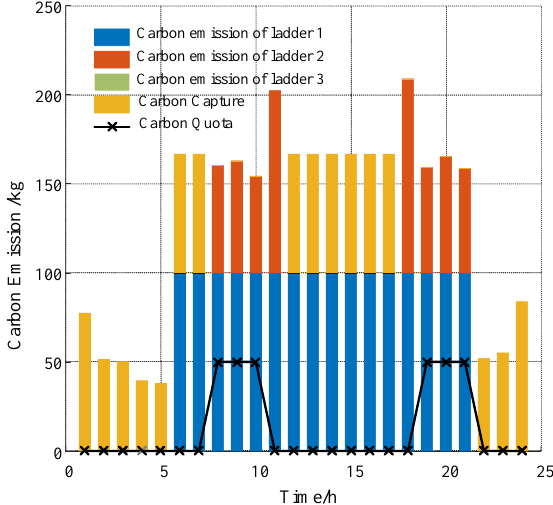
Figure 9. PIES optimal carbon emission plan.